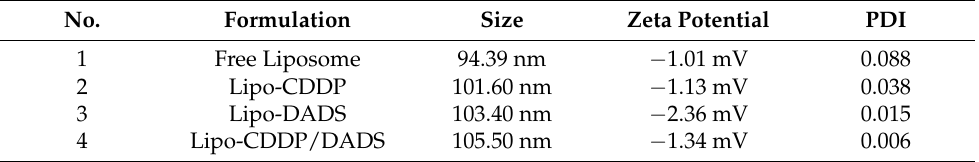
Table 1. Physical characterization of free liposome and drug-loaded liposomes. No.